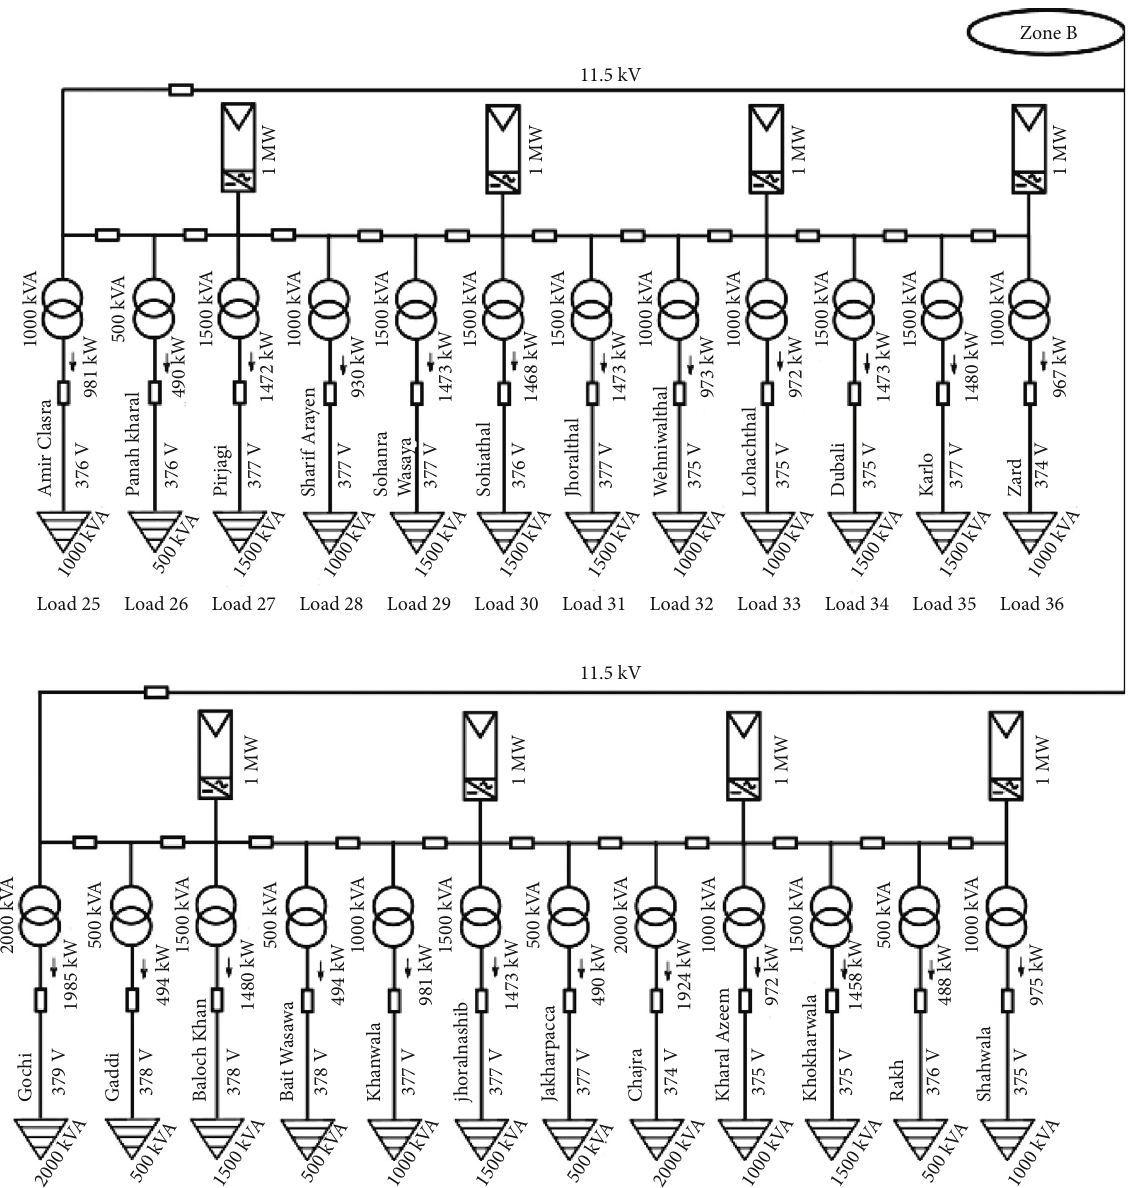
Figure 13: Implementation of zone B of the new system on 11 kW. Old transformer losses and new transformer losses for zone B are plotted in Figure 19(a).